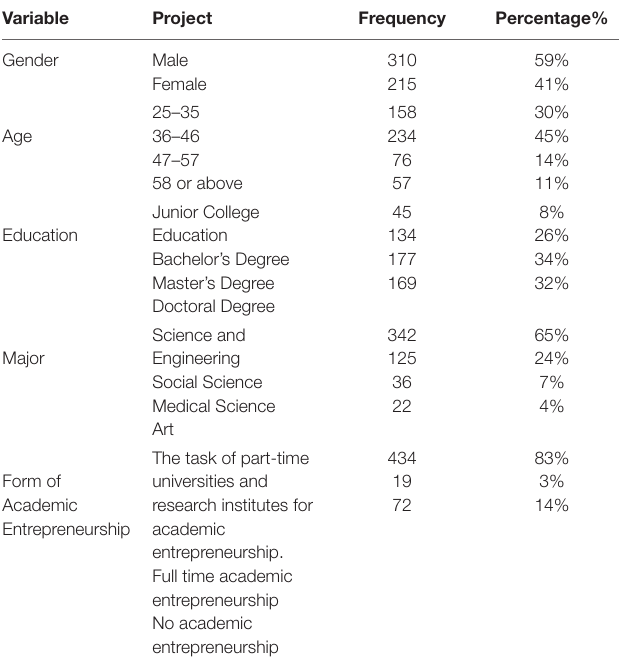
TABLE 1 | Descriptive statistics ( N =